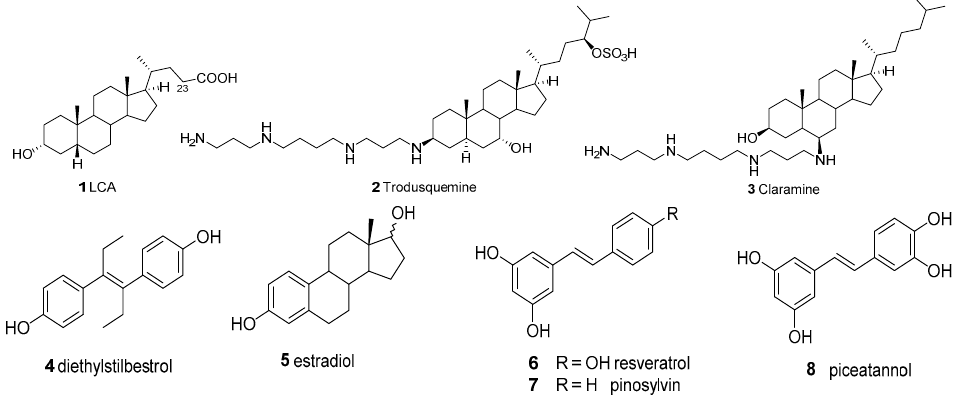
Figure 1. Steroids 1 ~ 3 reported as PTP1B inhibitors and stilbene derivatives 4 ~ 8 .